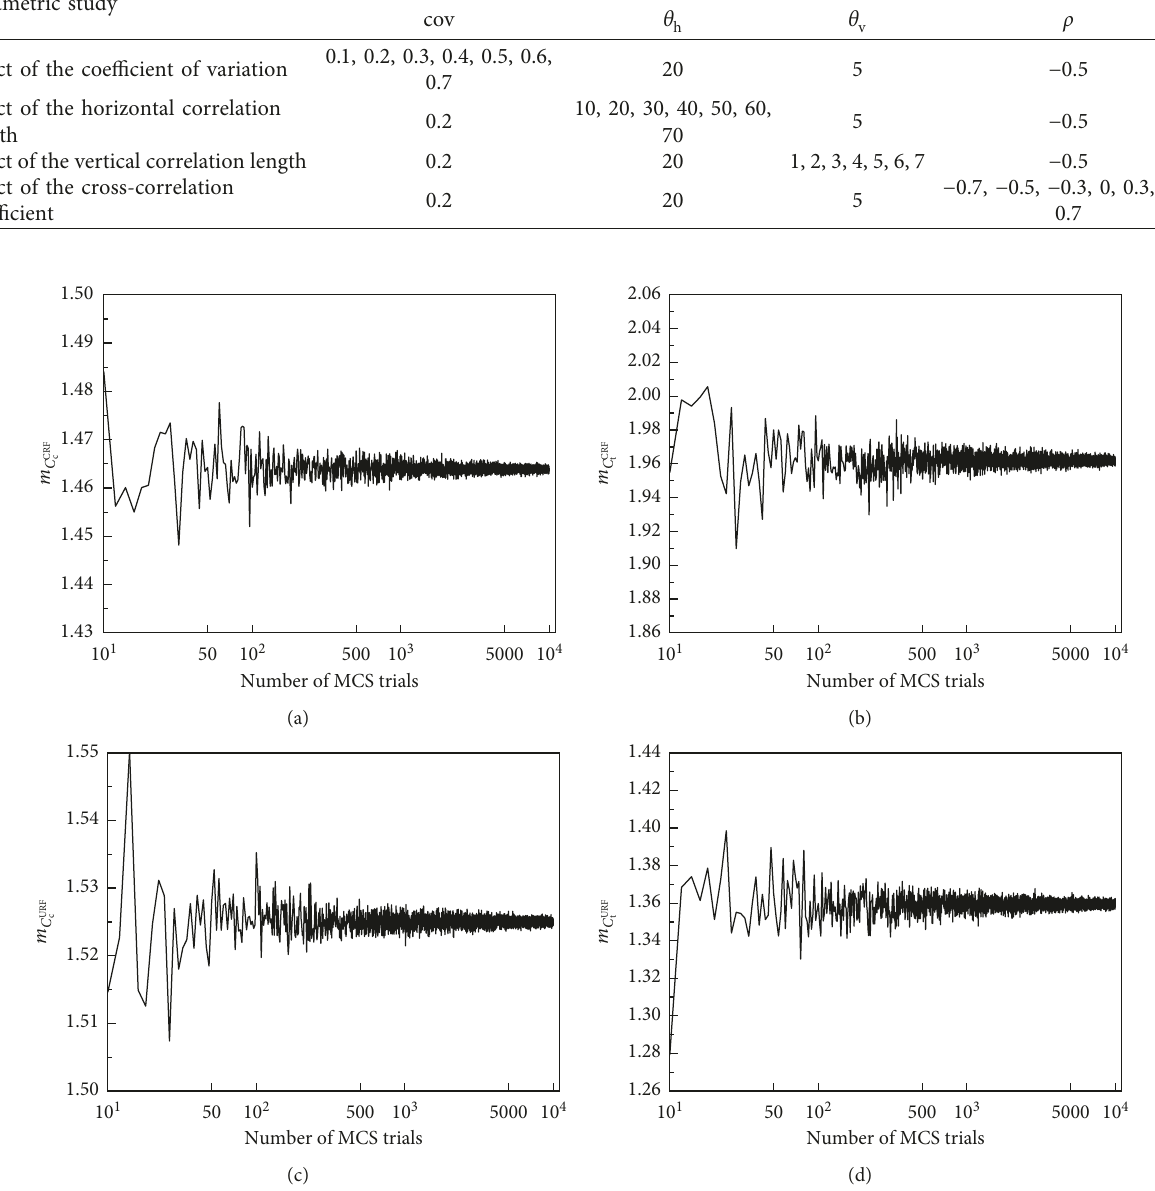
Figure 4: The sensitivity of mean strength factors to the number of MCS trials: (a) m